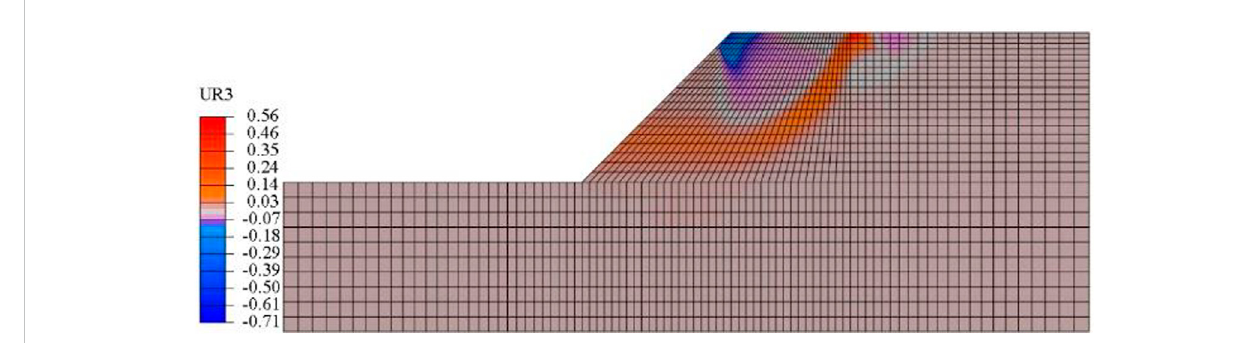
FIGURE 15 The rotation displacement simulated by multiscale FEM (mesh 2, l e = 0.1